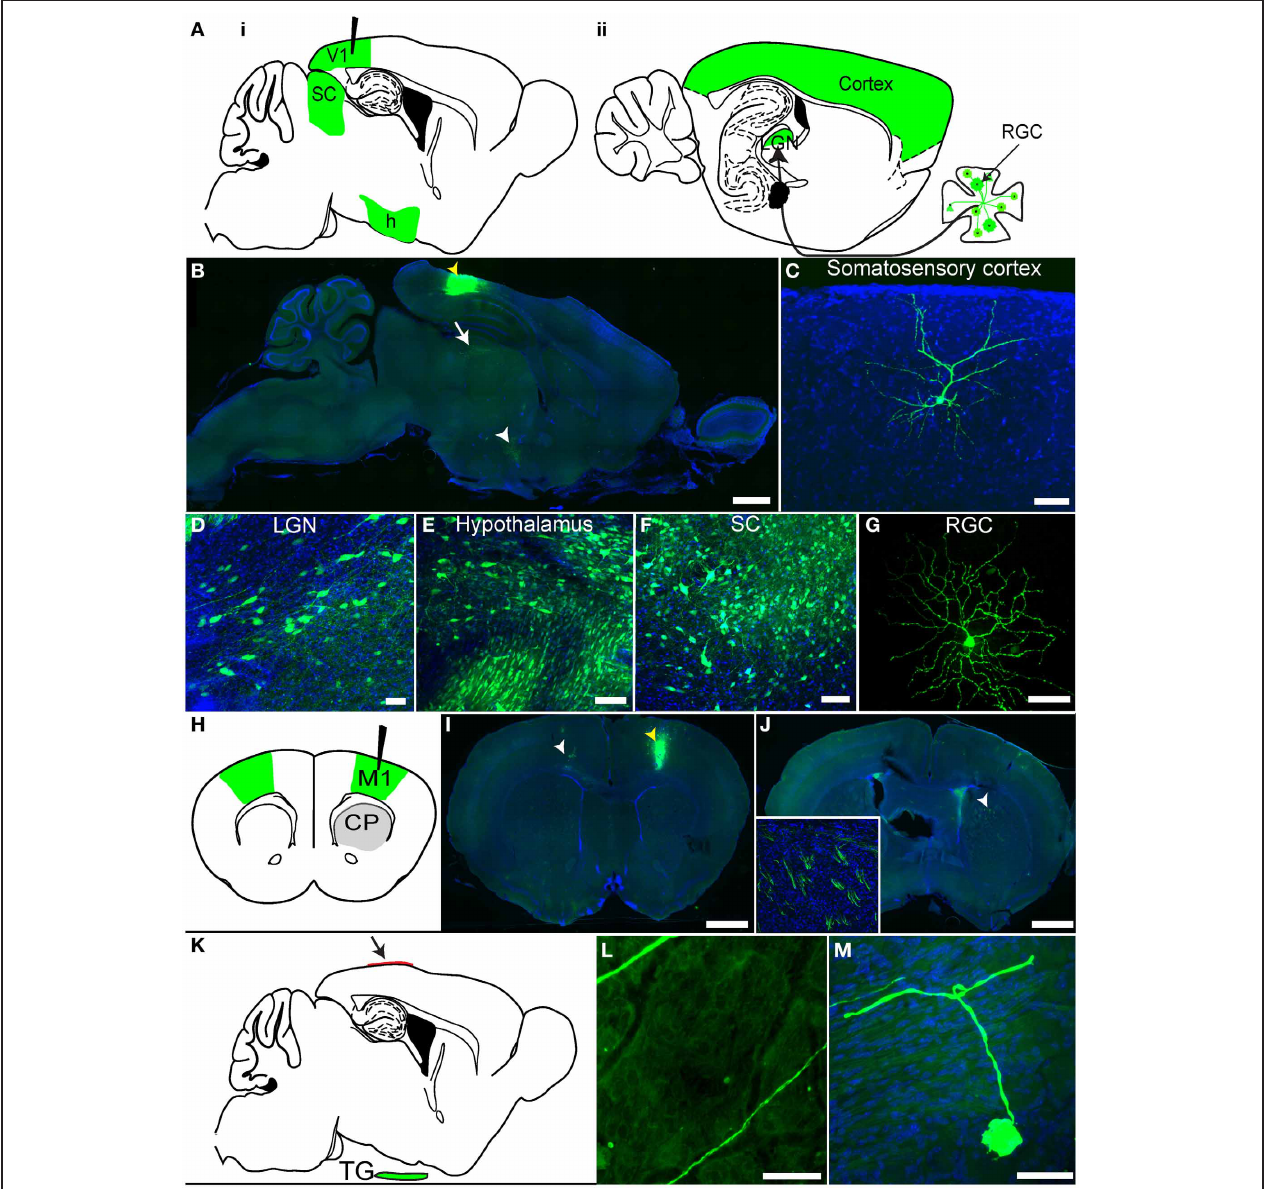
FIGURE 4 | rVSV(RABV-G) exhibits polysynaptic retrograde spread in vivo . (A) Schematics of two parasaggital sections separated by 1.3mm are shown. rVSV(RABV-G) injected into V1 (black needle) should yield infected cells in the labeled areas shown in green, including RGCs in the retina (panel ii ). Areas projecting directly to V1, such as the hypothalamus (h), LGN, as well as other cortical areas, can be labeled by direct retrograde uptake of injected virions, whereas RGCs, which project to the LGN, can only be labeled by secondary viral spread. (B) rVSV(RABV-G) was injected into V1 (yellow arrowhead), and both the brain and retina examined 7dpi. Infection in the brain appeared to be primarily in directly projecting areas, including the surrounding cortices, the LGN (white arrow), and hypothalamus (white arrowhead). Higher magnifications of labeled cells from a V1 injection are shown in panels (C–G) . (C) somatosensory cortex, 7dpi; (D) LGN, 3dpi; (E) hypothalamus, 3dpi; (F) SC, 3dpi; (G) RGC, 3dpi. (H) Schematic of a coronal section showing rVSV(RABV-G) injected into M1 (black needle). The contralateral cortex (green) should be labeled by this virus, while at early time points such as 2dpi, the CP,